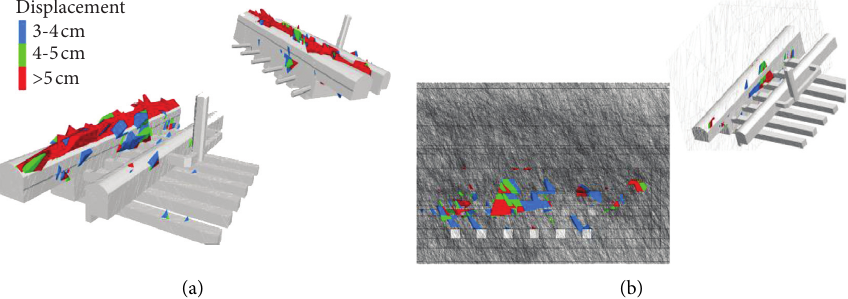
Figure 4: The unstable blocks distribution after the full excavation. Overall visualization of different displacements of blocks distribution (a); different displacements of blocks distribution along downstream sidewall of the main powerhouse cavern